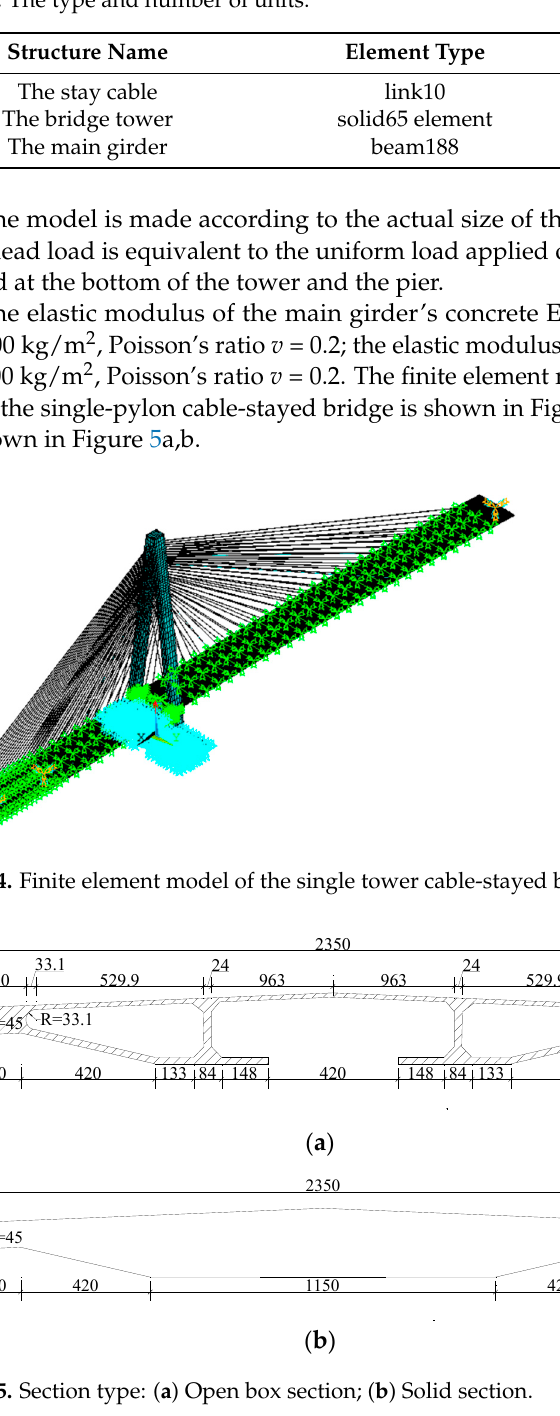
Table 1. The type and number of units.